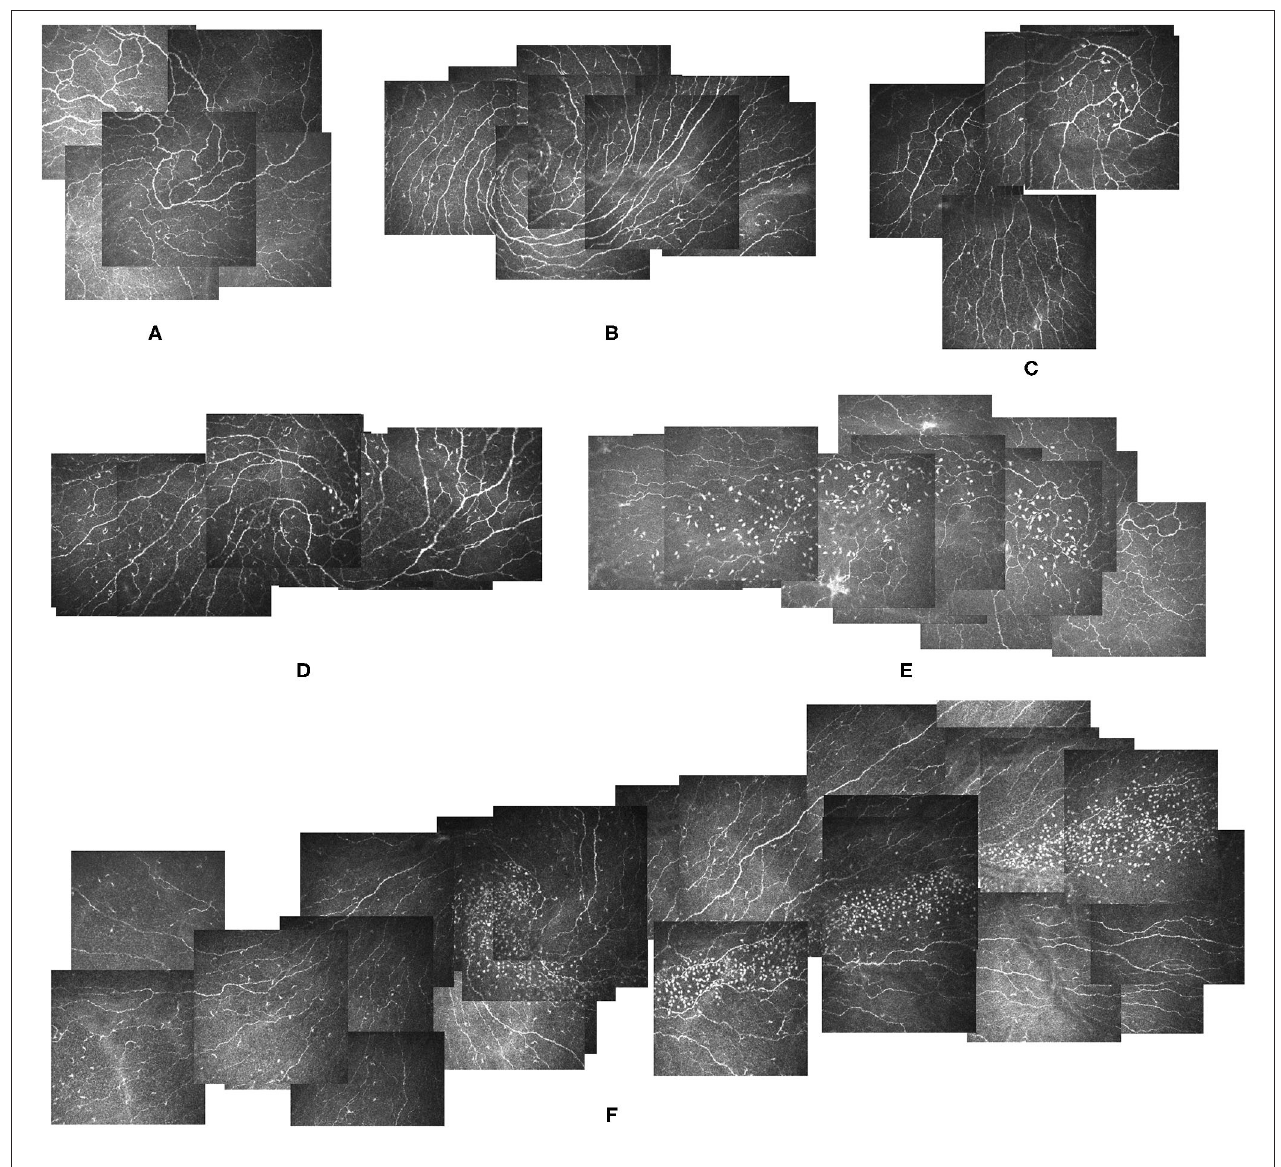
FIGURE 2 | Different types of globular cells distribution patterns in the corneal vortex. (A) Image from a 34-year-old male participant showing a Non-globular cell pattern and a clear vortex with no globular cells. He had no LCs. (B) Image from a 29-year-old male participant showing a Non-globular cell pattern with LCs. (C,D) Images from a 36-year-old female participant showing a type 1 globular cells distribution pattern, scattered globular cells around the vortex area with LCs (D) and without LCs 2 months after treatment (C) . (E) Image from the right eye of a 57-year-old female participant showing a type 2 globular cells distribution pattern, with a large number of globular cells gathering within the vortex and distributing along the nerve horizontally in the temporal direction. She had no LCs in the vortex. (F) Image from the left eye of a 41-year-old female participant showing a type 2 globular cells distribution pattern with LCs in the vortex. The globular cells were distributed horizontally along the nerve in the temporal direction. LCs: Langerhans